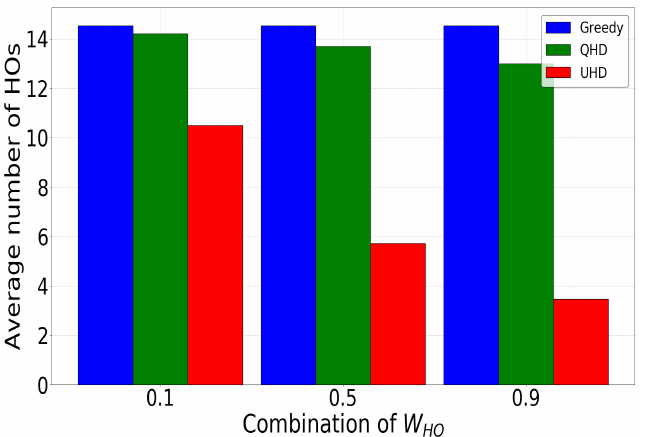
Figure 6. Comparative analysis among UHD, QHD, and greedy methods for the average number of handovers (HOs) in the exploitation